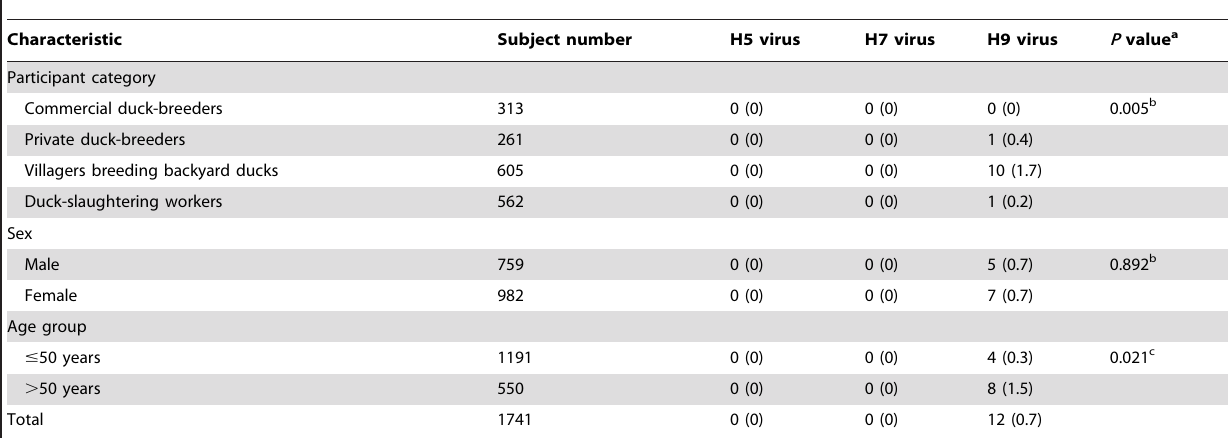
Table 2. Seroprevalences of antibodies to H5, H7 and H9 viruses in duck-related workers in the serological survey in Beijing, China.